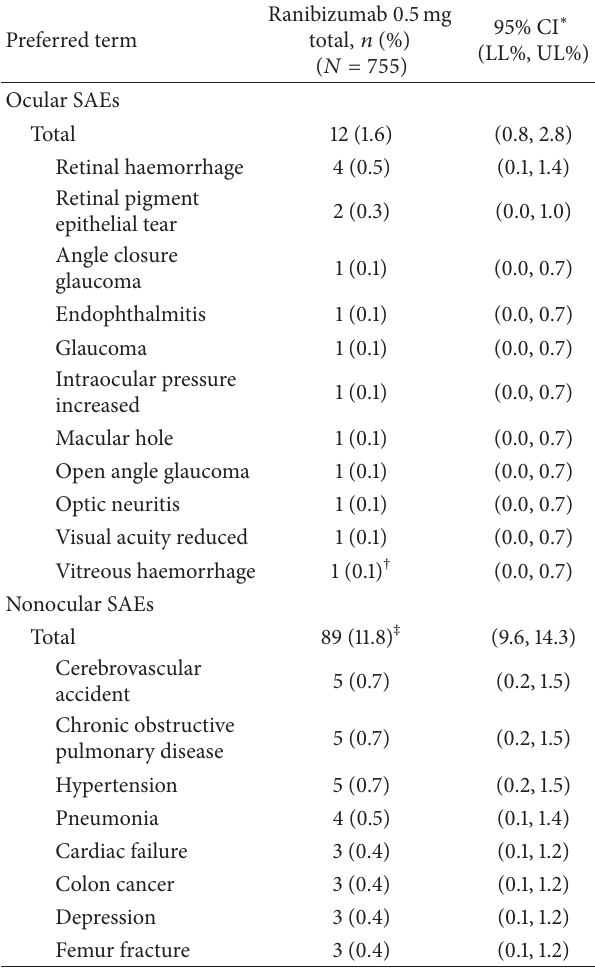
Table 5: Patients with ocular SAEs and frequent nonocular SAEs ( ≥ 3 patients) over 2 years (safety set, first-treated